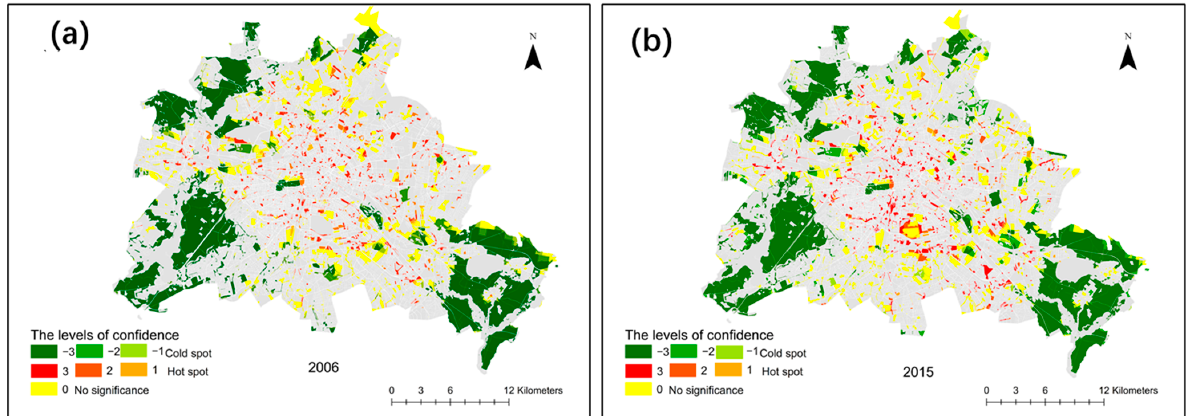
Table 2. Pearson analysis of LST, NDVI and PA in 2005 and 2015.